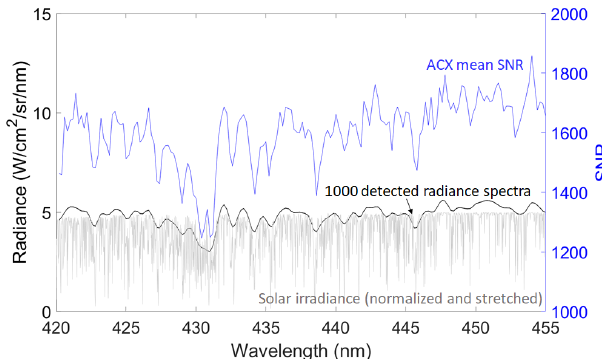
Figure 4. Example of at-sensor radiance spectra simulated with an applied instrument model including resampling effects and an added noise set by ACX instrument parameters. A total of 1000 spectra are plotted (black lines), which appear as lines slightly thicker than the mean SNR (blue line and right axis). The normal- ized solar irradiance multiplied by a factor of 5 is shown for com- parison to the resampled